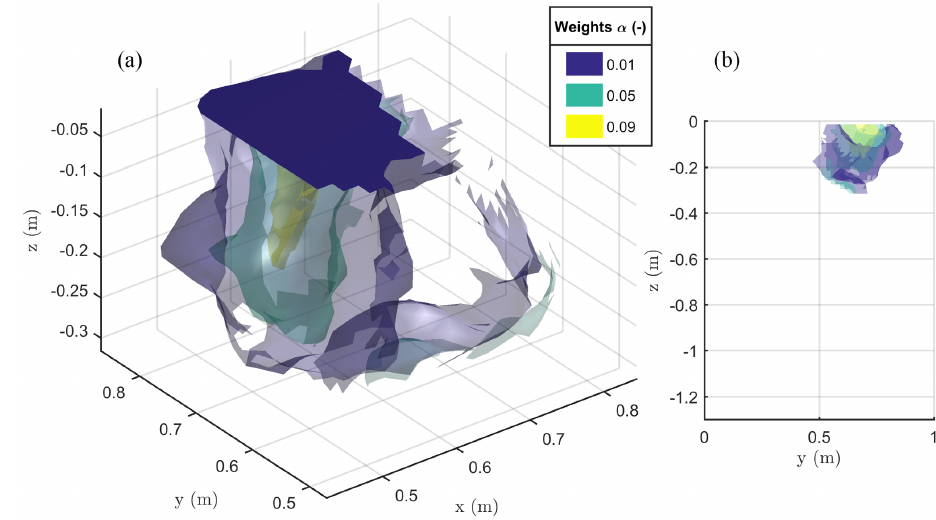
Figure 9. The 3-D view (a) and 2-D Y–Z view (b) of the iso-surfaces of current source contribution α after minimization of the objective function F2 as defined in Eq. (2). The results are relevant to the stem current